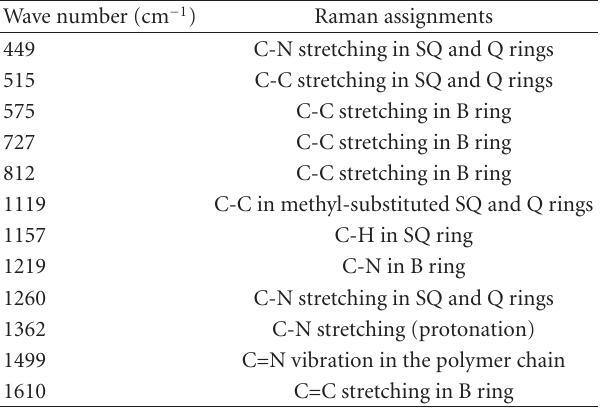
Table 1: Assignments of FT Raman bands of electrodeposited POT films.